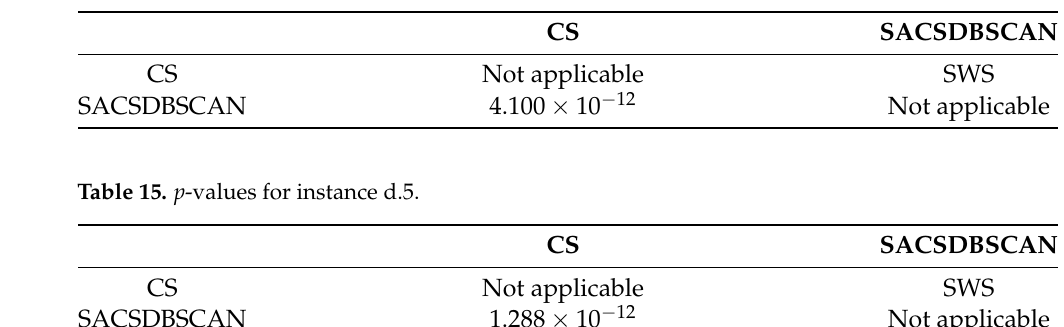
Table 14. p -values for instance c.5.